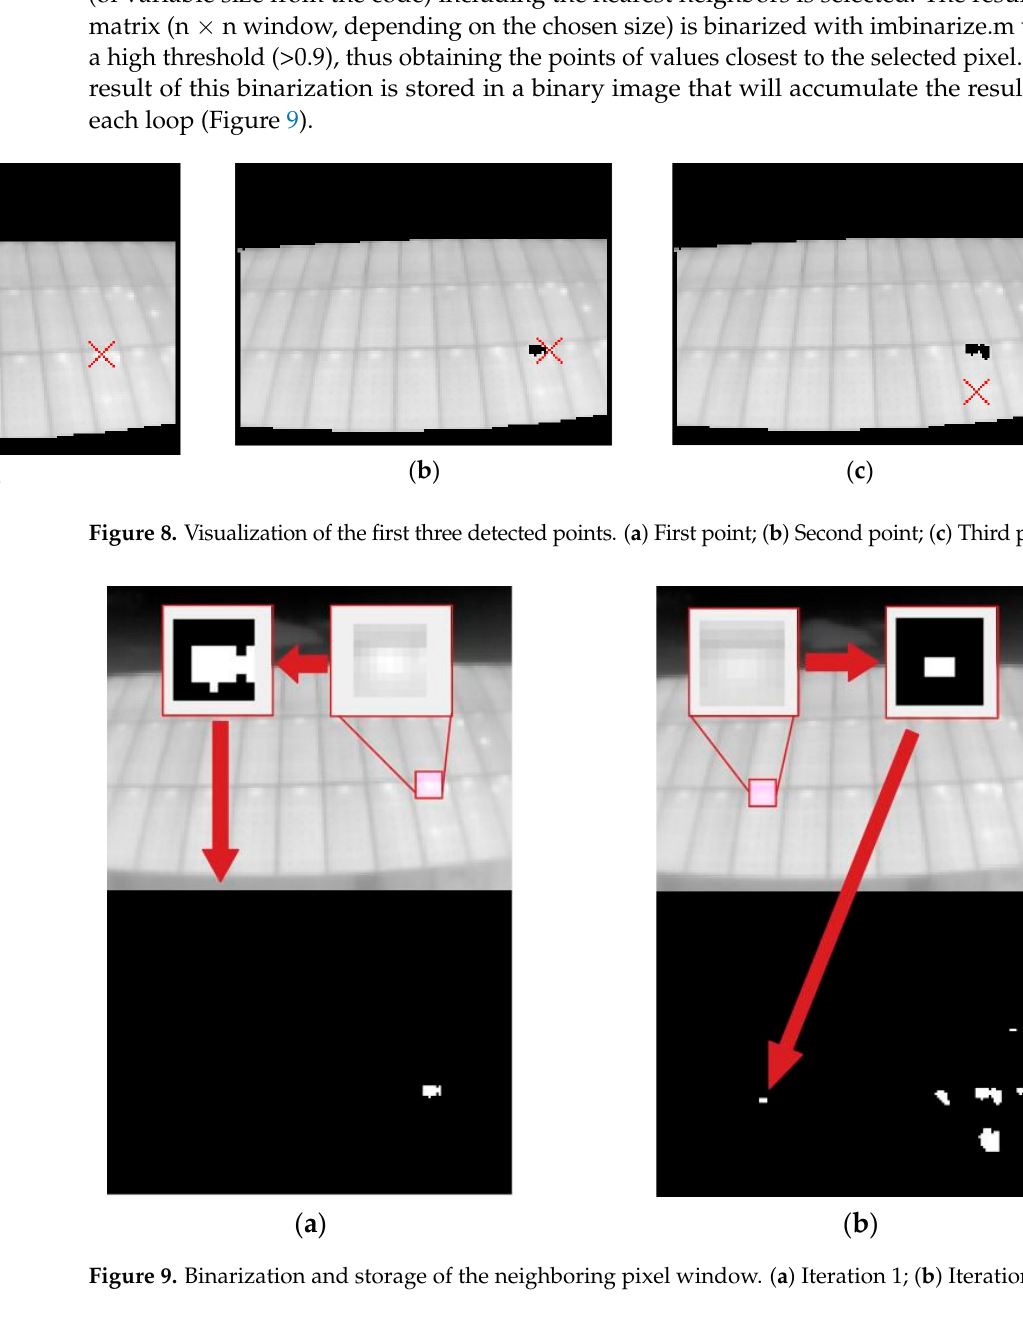
( d ) Figure 7. Example 1 of the final result of the automatic segmentation. ( a ) Raw image; ( b ) Edges thicked; ( c ) Area of interest; and ( d ) segmented image. 2.2.3. Algorithm for Hot-Spot Detection Once the area where the hot-spots are to be searched is segmented, an algorithm ca- pable of labeling a certain number of hot-spots in an image and displaying their temper- ature is developed. For this purpose, a function is developed in MATLAB that will use the resources reviewed in previous sections for the conditioning, segmentation, and recogni- tion of the thermographies made. The algorithm works in such a way that it always pri- oritizes the search for the hottest point, then keeps detecting points up to a user-specified amount. In addition to the number of detected points, the number of attempts for recog- nition and the limit temperature can also be configured, so that not only the hottest point can be displayed but all points below a threshold. Additionally, the physical characteris- tics of each detected hot-spot such as area, longest axis, shortest axis, and inclination with respect to the X -axis can be accessed. Initially, the code executes all the image loading, correction, and processing instruc- tions. Next, it segments the ROI and applies the search and labeling algorithm. The latter consists of two steps: the search and segmentation of the detected objects (hot-spots) and